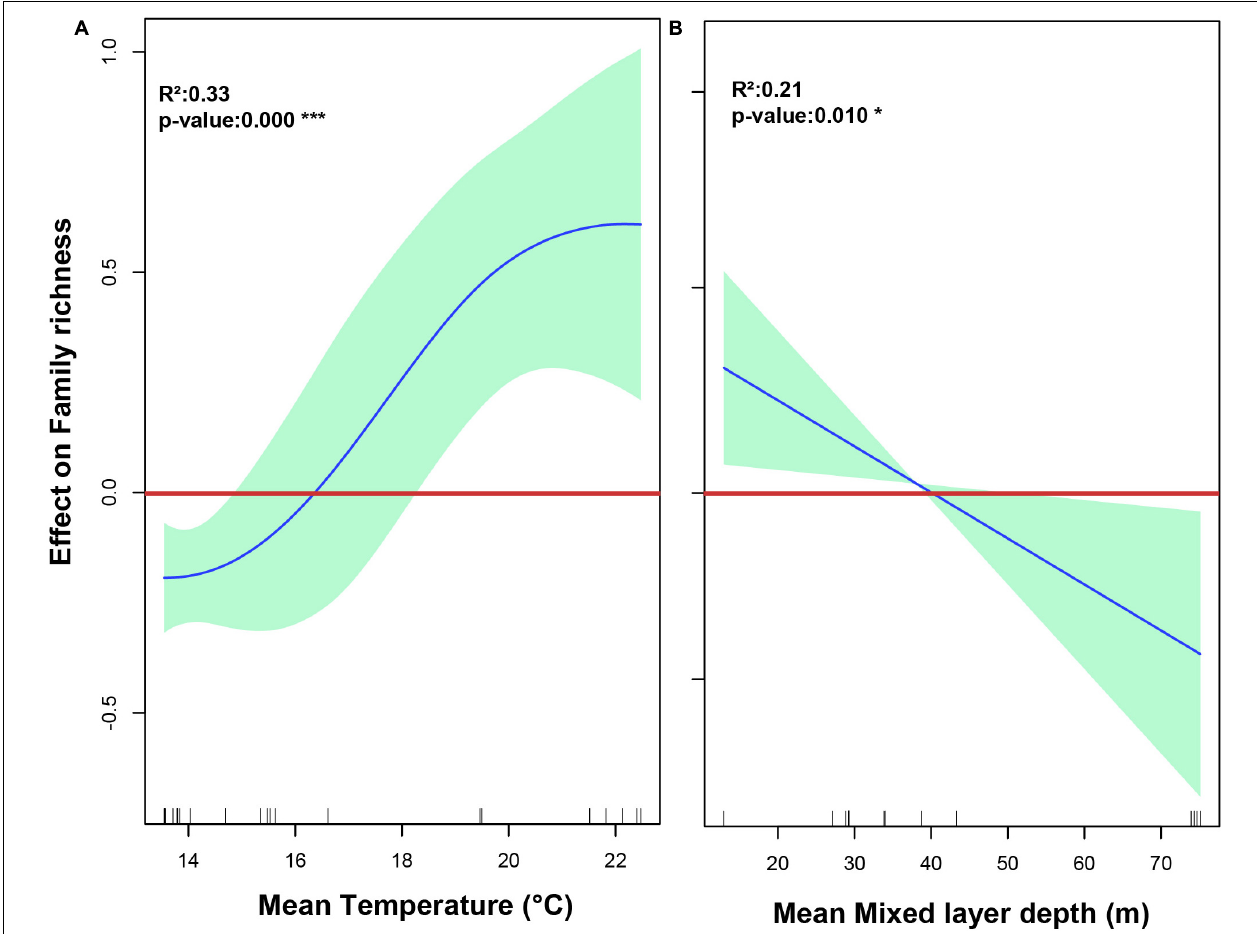
FIGURE 9 | The relationship between oceanographic variables and family richness of calanoid copepods found in the 0–200 m layer in the southeast Pacific, as represented by a generalized additive model (GAM). (A) The effect of Mean sea surface temperature on family richness. (B) The effect of mean depth of the mixed layer on family richness. Spline fit (solid blue line) is bound at 95% confidence intervals (light green area). Values > 0 indicate a positive effect on richness, values < 0 indicate a negative effect. The rug plot (dashes above the x -axis) represents the distribution of data